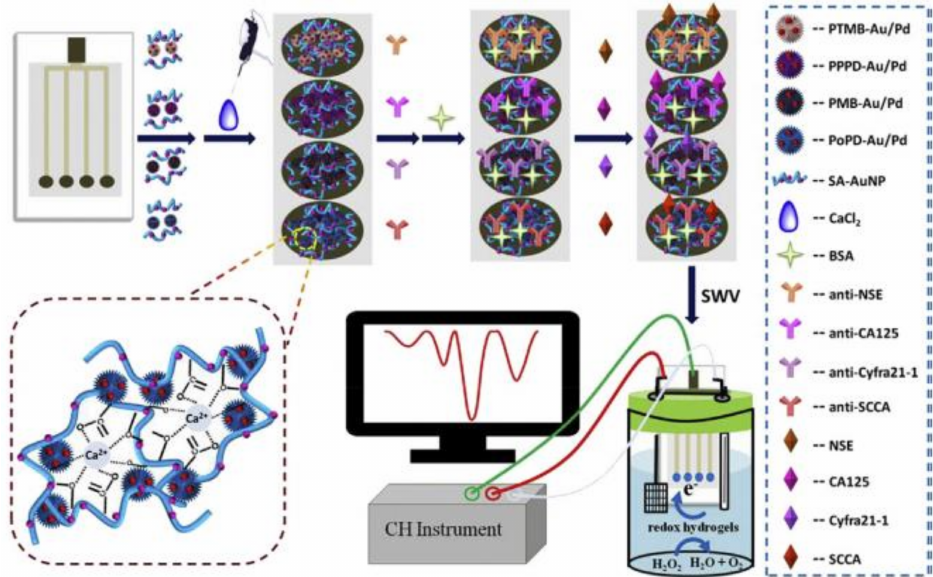
Figure 4. Multiplexed label-free amperometric immunosensor based on SPCE modified by Au- pd NPs and some polymeric matrices for the detection of some biomarkers. Reproduced from Reference [31] with permission. Copyright 2018,